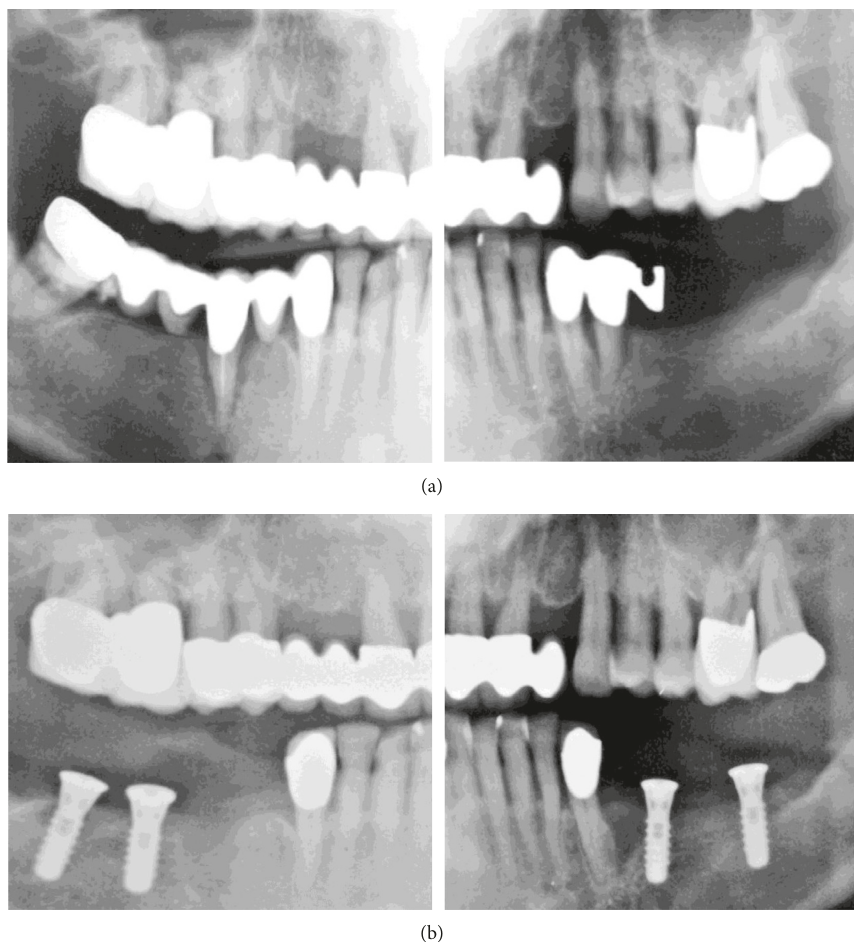
Figure 1: OPGs (original OPG of previous treatment modified for presentation reasons). (a) Before the initiation of previous treatment (January 2004). (b) After mandibular tooth extraction and implant placement (April